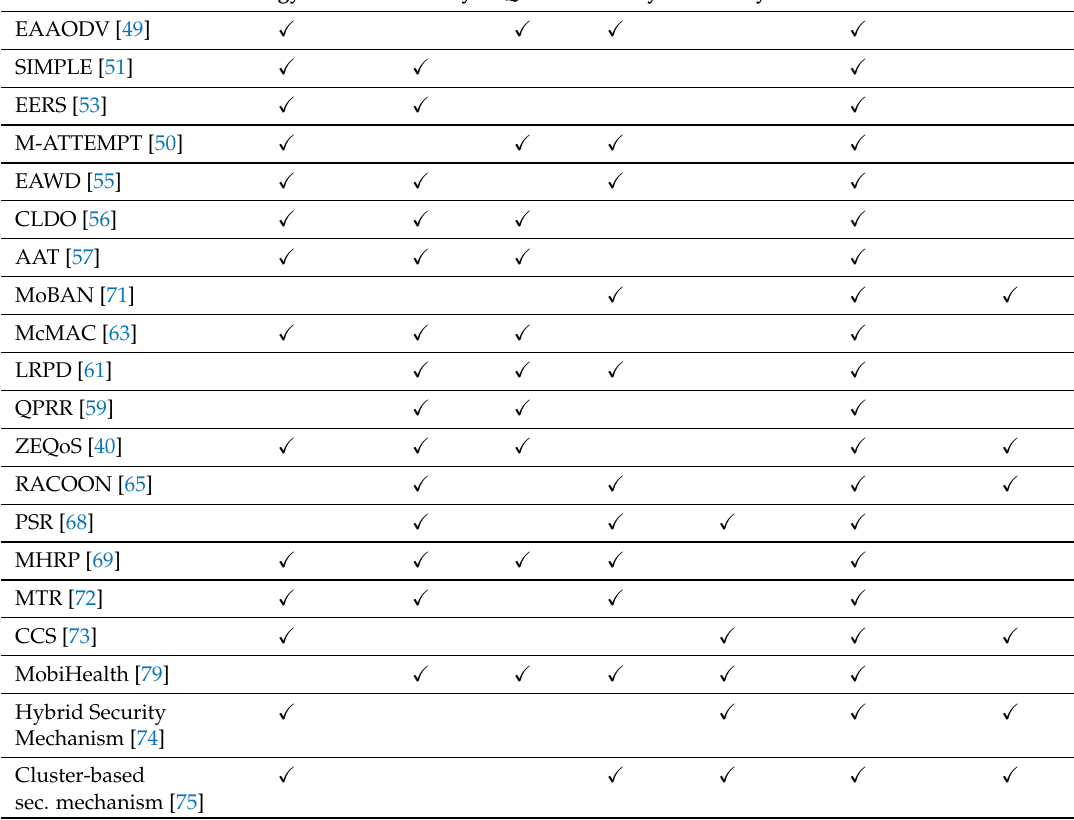
Table 3. Comparison of existing wireless body area network (WBAN) solutions to be extended to the BBN environment. c (cid:13) [2019] IEEE. Reprinted and modified, with permission, from [4].